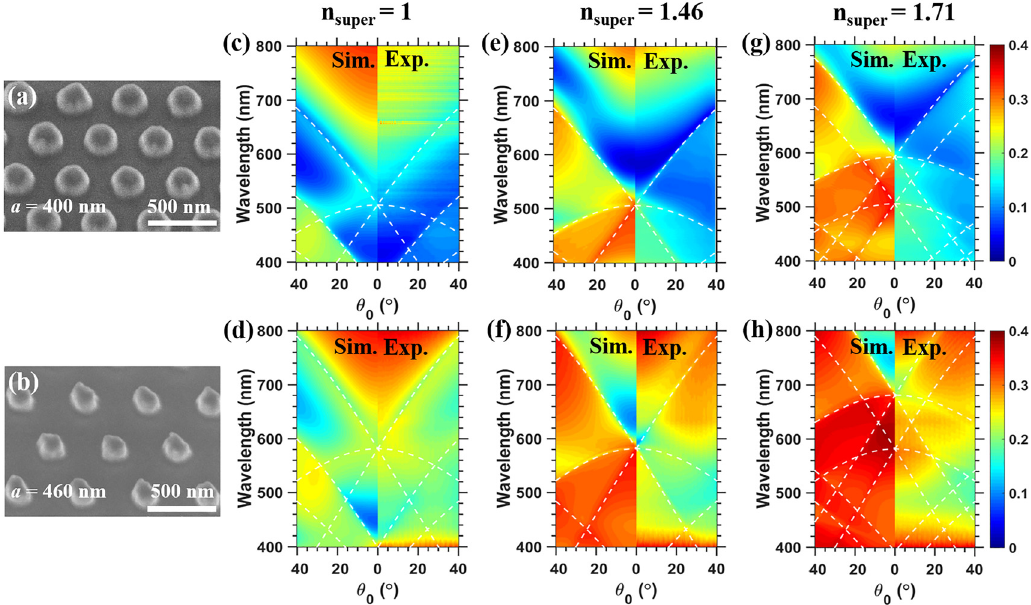
Figure 2: The 30 ° -tilted scanning electron microscopy (SEM) images of Al nanoparticle (NP) hexagonal array after the deposition of 7.5 nm Fe fi lmwithlatticeconstant a =400nm(a)and460nm(b).Thecalculated(Sim.)andexperimental(Exp.)transmissionspectraasafunctionof θ for the Al NP array with a 7.5 nm thick Fe fi lm on the top with n super = 1, 1.46, and 1.71 respectively for a = 400 nm (c, e, g) and 460 nm (d, f, h). Whitedashedlinesindicatetheconditionsofin-planediffraction(thespeci fi cmodesareindicatedinAppendixFigureS5),andthecolorbaris uniformly indicated on the right side of each